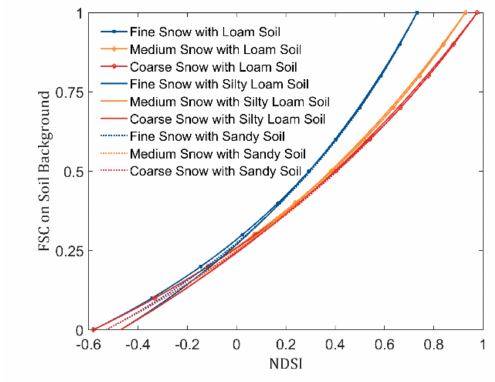
Figure 4. Fractional snow cover versus normalized di ff erence snow index (NDSI) on soil background.